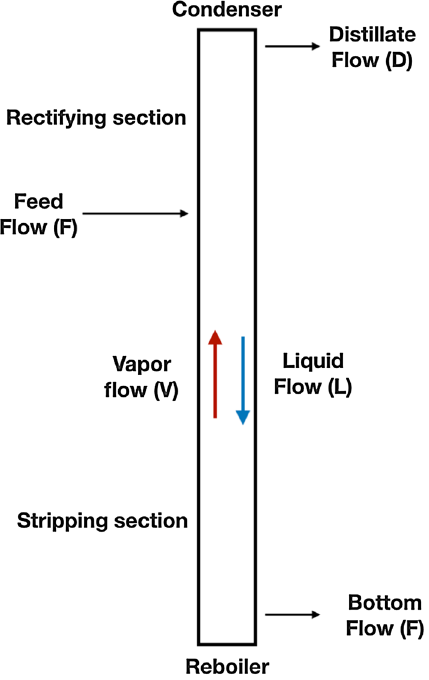
Fig. 1 Basic operation principles of a continuous distillation column